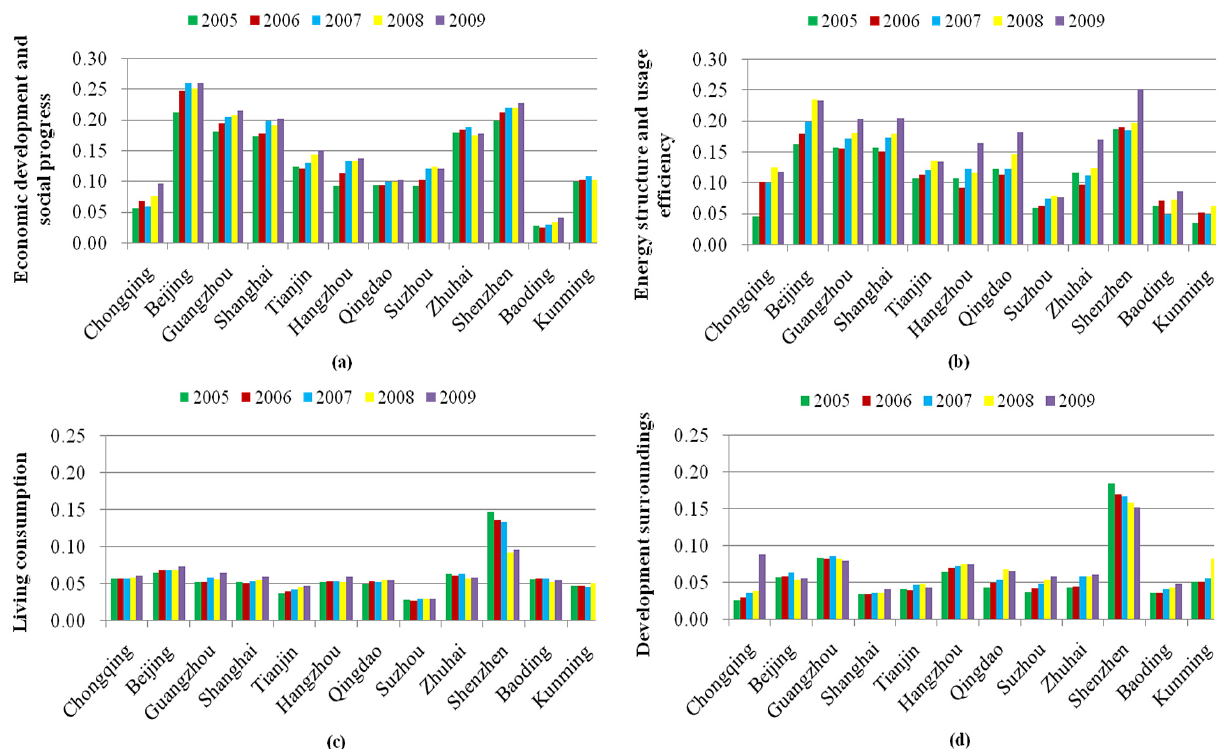
Figure 2. Results of different aspects of urban low-carbon development level for 12 cities during 2005–2009. ( a ) Economic development and social progress, ( b ) energy structure and usage efficiency, ( c ) living consumption, and ( d ) development